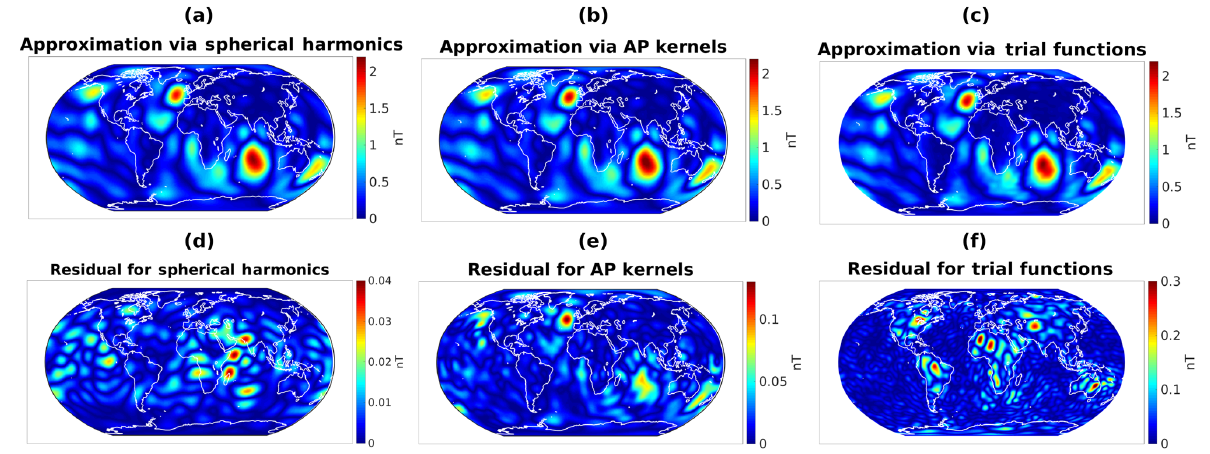
Figure 6. Absolute value of the radial part of approximations of B CM5 oc based on dictionary D 1 (a) , dictionary D 2 (b) , and dictionary D 3 (c) , as well as the corresponding residuals with respect to B CM5 oc (d, e, f) . Note the different scales in the bottom row which are chosen in order to emphasize the spatial distribution of the